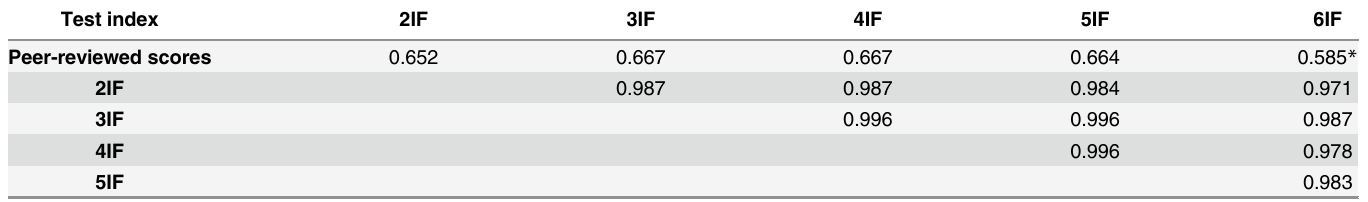
Table 2. Correlations between the peer-reviewed scores of 28 journals and impact factors with different citation time windows. Test